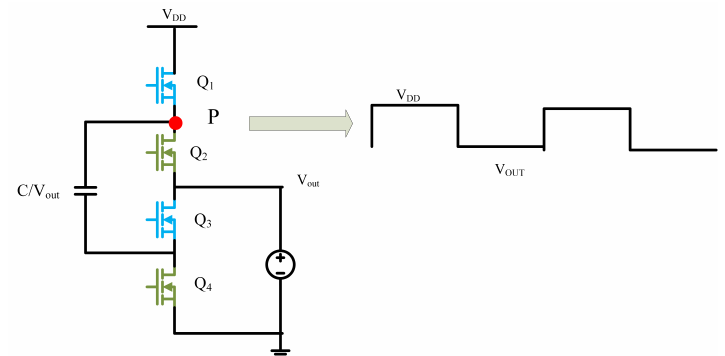
Figure 5. Voltage waveform of node P in 2-to-1